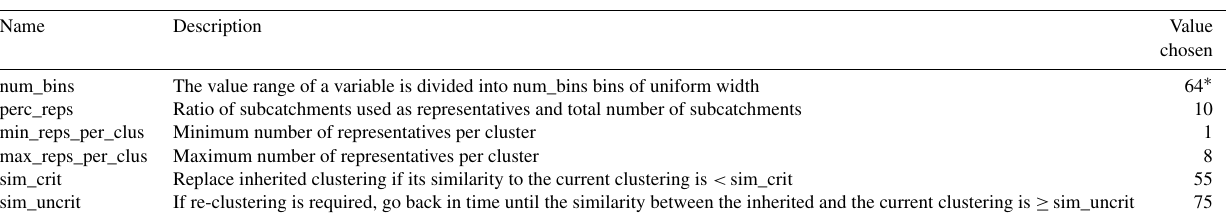
Table 1. Parameters of adaptive clustering and their values for SHM